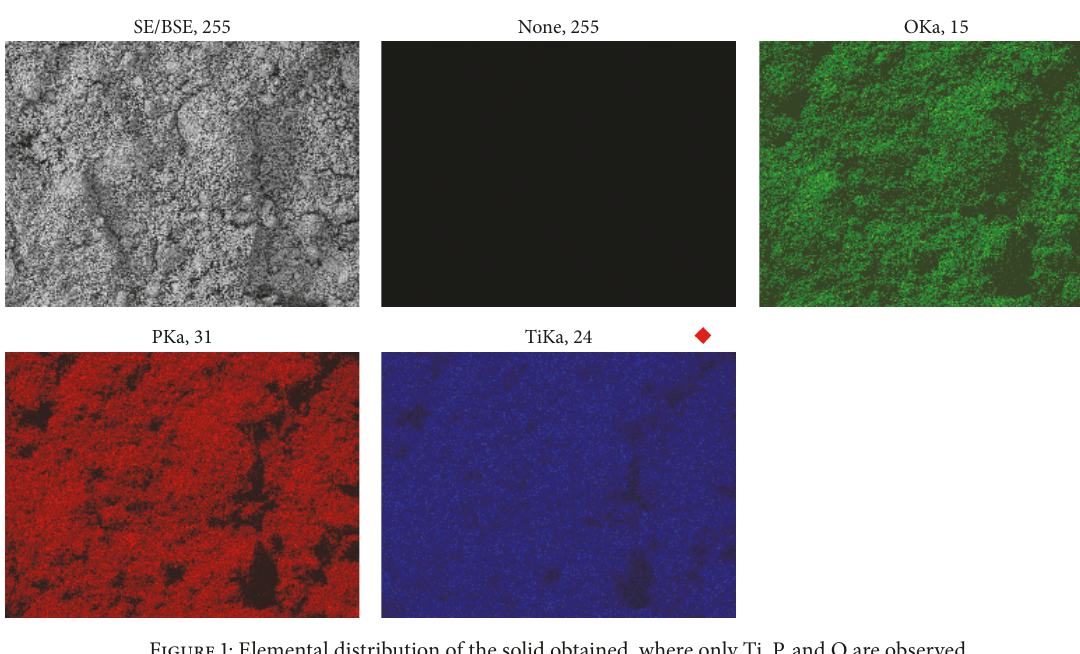
Figure 1: Elemental distribution of the solid obtained, where only Ti, P, and O are observed.